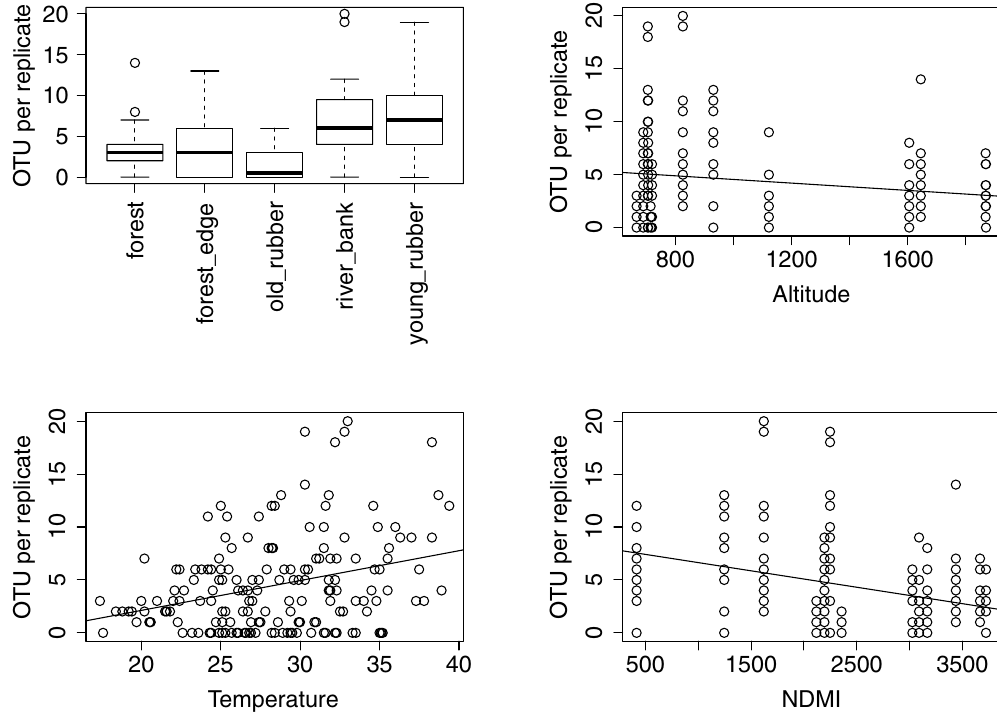
Figure 4. Number of bee MOTU in each malaise replicate, according to ( a ) habitat; ( b ) altitude; ( c ) temperature; ( d ) NDMI (vegetation density index).